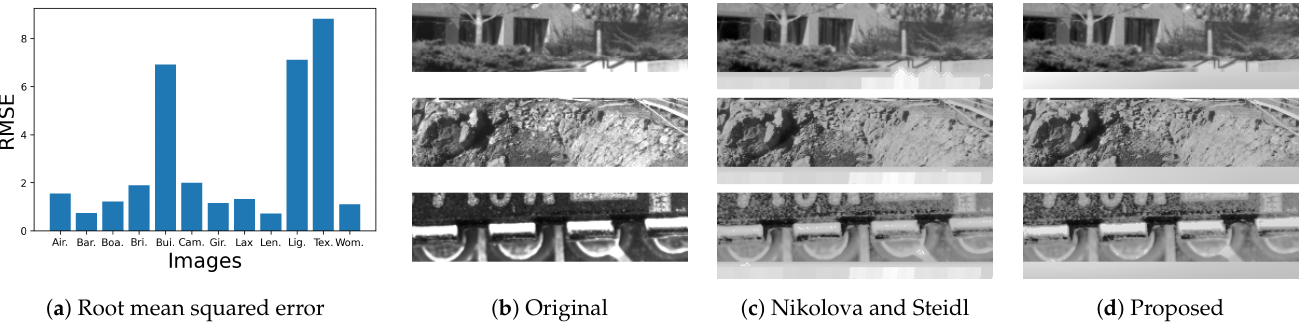
Figure 19. Comparison between Figures 17 and 18: ( a ) RMSEs of twelve grayscale images; ( b ) The bottom areas of the original “Bui.”, “Lig.” and “Tex.” images are arranged from top to bottom; ( c ) the same parts of the results by Nikolova and Steidl’s method; ( d ) the same parts of the results by the proposed methods.